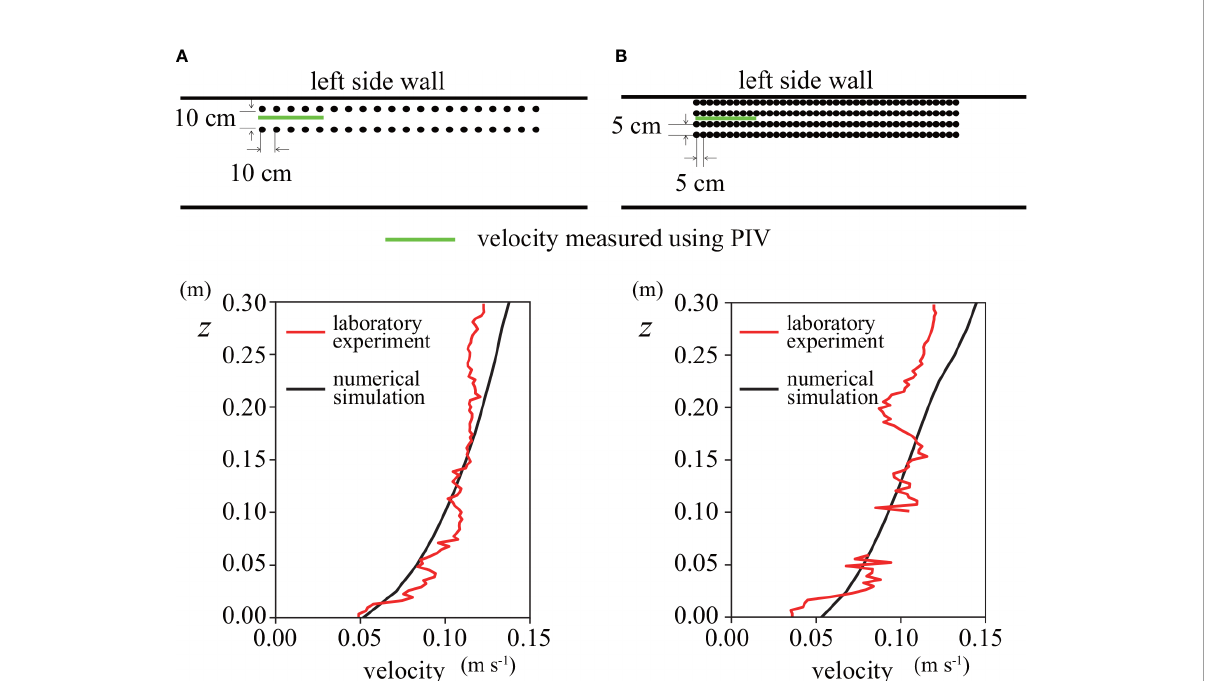
FIGURE 4 Comparison of the vertical pro fi les of horizontal velocities between laboratory experiments and numerical simulations. Red and black lines indicate the laboratory experiment and the numerical simulation, respectively. (A) Case E1, (B) Case E2.